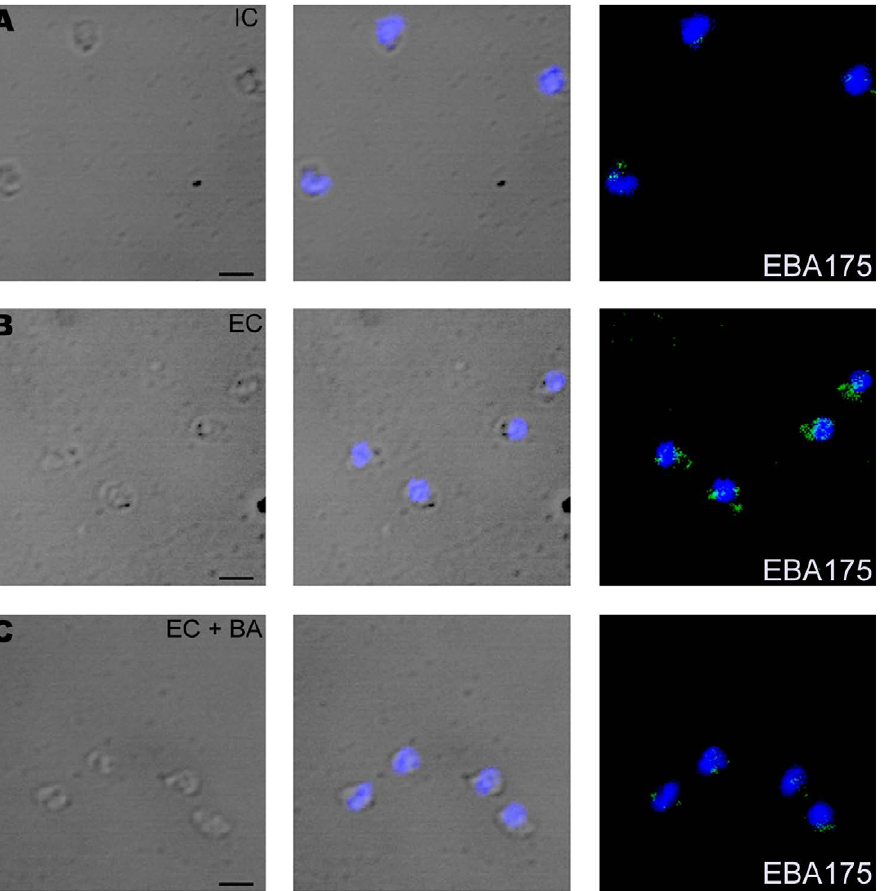
Figure 5. Expression of EBA175 on merozoite surface detected by immunofluorescence assay (IFA) in response to changes in ionic conditions. Expression of microneme protein EBA175 on surface of P. falciparum merozoites isolated in IC buffer (IC) ( A ) or following transfer to EC buffer (EC) ( B ) or following transfer to EC buffer after pre-treatment with BAPTA-AM (EC + BA) ( C ) was detected by IFA using anti-EBA175 rabbit sera followed by FITC-conjugated anti-rabbit IgG goat sera (green). Nuclear DNA was counterstained with DAPI (blue). Bright field, bright field merged with DAPI staining and merged fluorescence images (DAPI and FITC) are shown. Black bar indicates 2 m m.